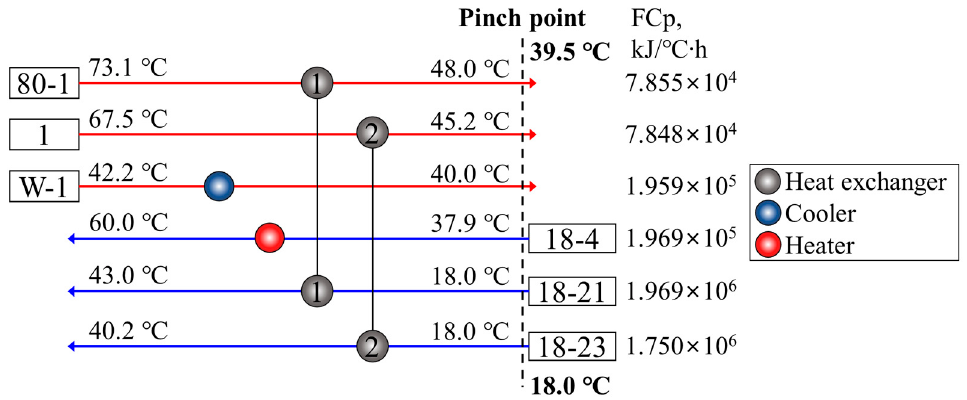
Figure 3. Grid diagram of HEN in the wastewater heat recovery system before retrofitting.